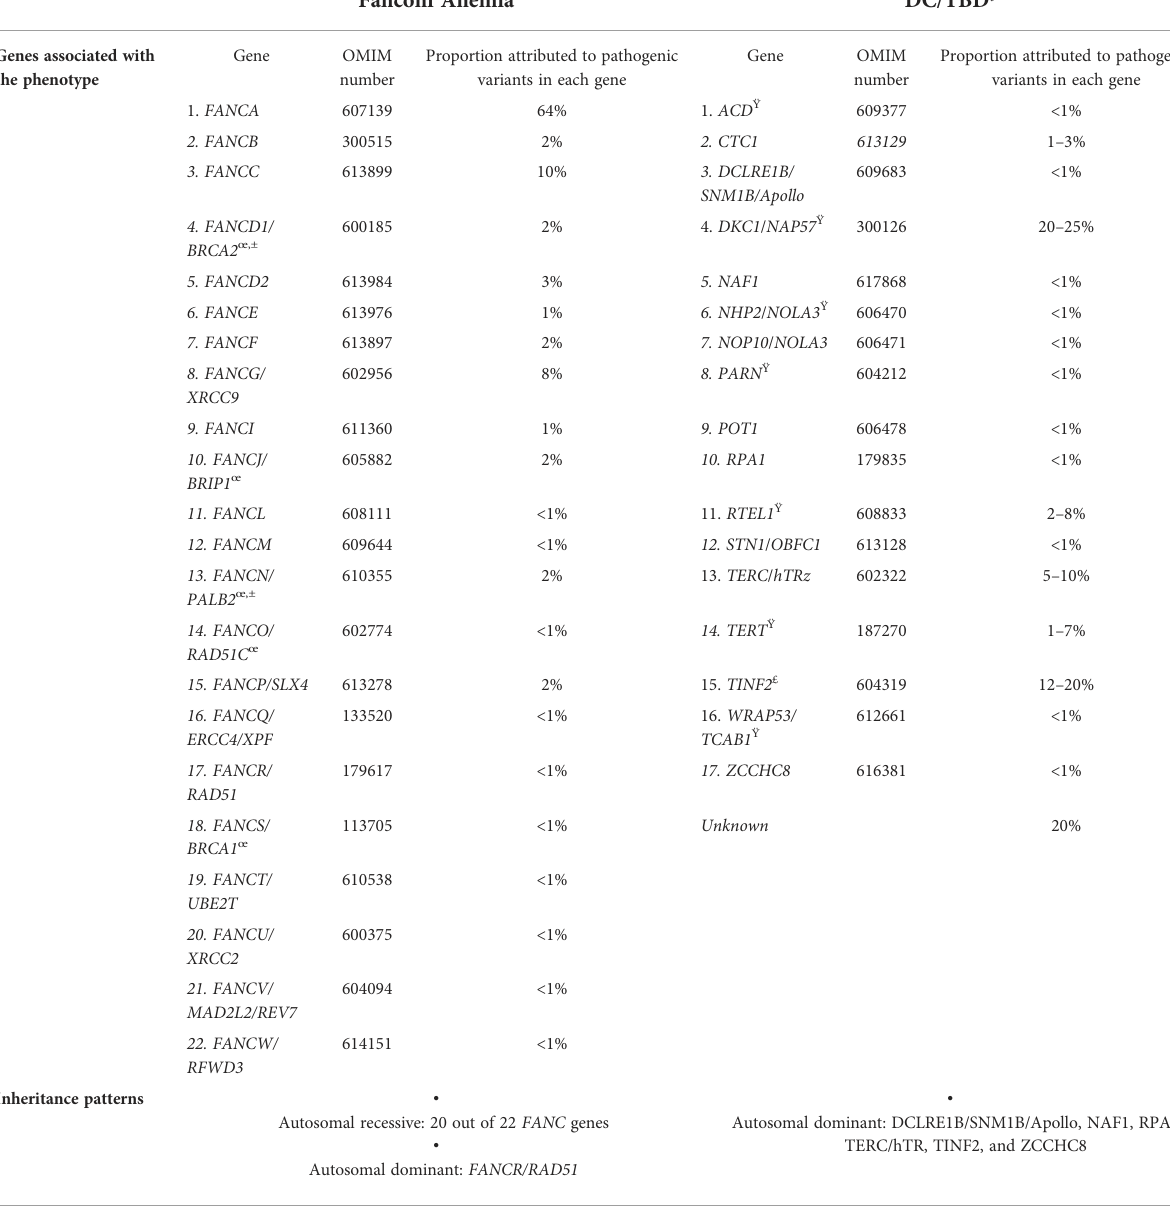
TABLE 2 Genes, inheritance patterns, pathophysiology, and diagnostic